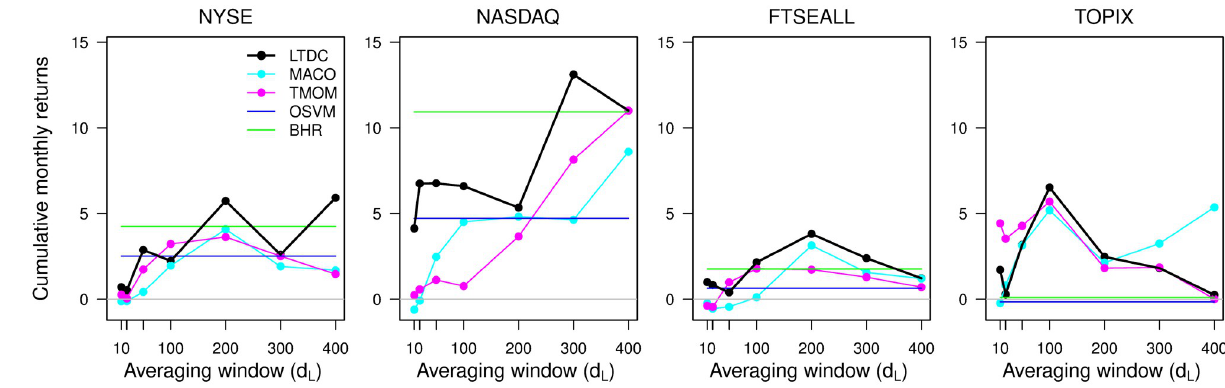
Fig 5. Cumulative monthly returns by market and averaging